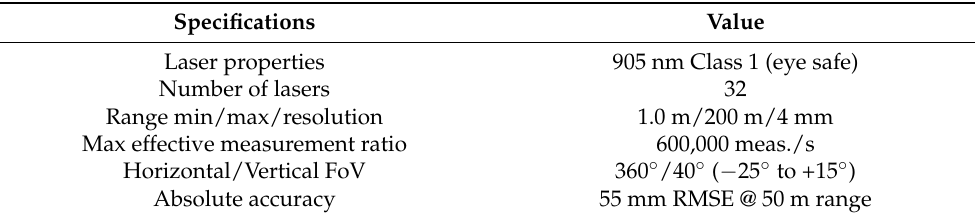
Table 2. Technical specifications of the self-generated drone LiDAR